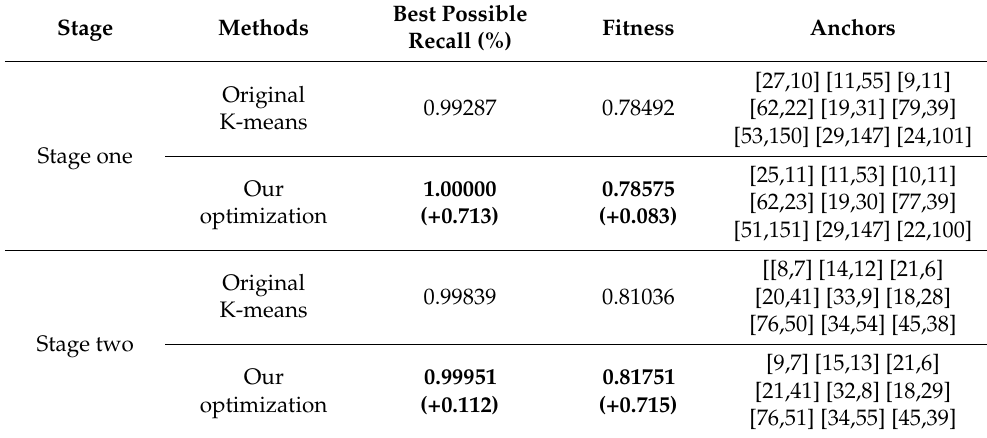
Figure 13. Visual comparison results of two-stage data clustering. ( a ) The results of one-stage an- chors of K-means clustering; ( b ) The results of one-stage and genetic algorithm improvement; ( c ) The results of two-stage anchors of K-means clustering; ( d ) The results of two-stage anchors and genetic algorithm improvement. Table 1. Comparison of clustering results of improved ( 1 − IOU ) and Genetic